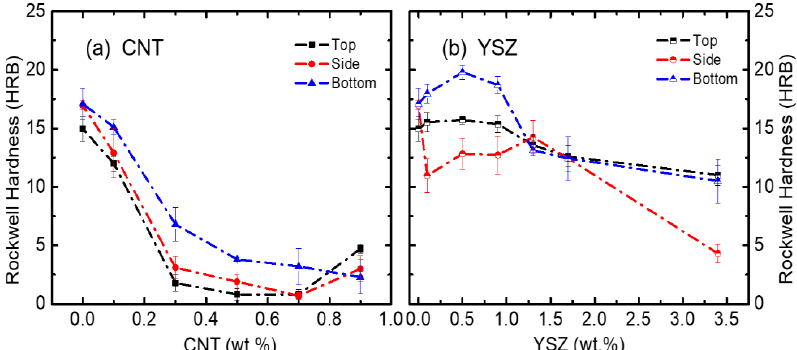
Figure 6. Variation of Rockwell hardness with increasing contents of ( a ) CNT and ( b ) YSZ particles, respectively, at top, side, and bottom regions of 3D-printed teeth. Rockwell hardness decreases with increasing CNT content, whereas it shows hardness enhancement for YSZ-added specimens, especially at the top and bottom regions when YSZ content is lower than 0.9 wt.%.